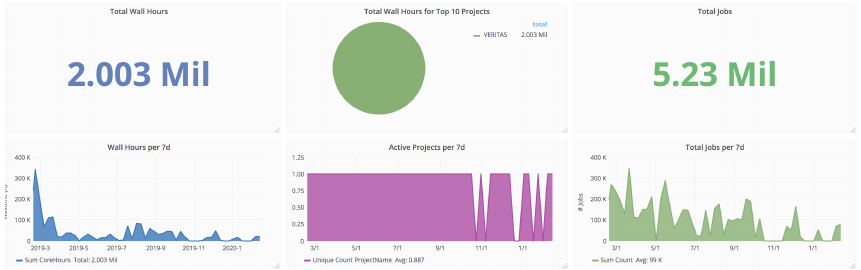
Figure 5. The VERITAS project consumed over 2 million compute hours on OSG over the past year and submitted over 5 million condor jobs to the